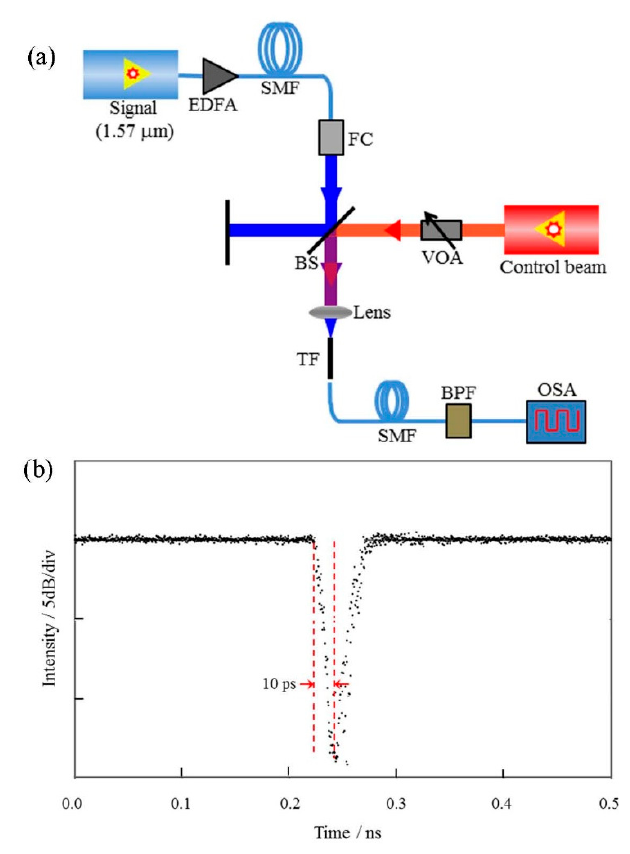
Figure 7. ( a ) Experimental setup for investigating the all-optical signal modulation controlled by the ultrafast single pulse in the all-solid double-clad tellurite PBGF. ( b ) Experimental results of the all-optical signal modulation controlled by the ultrafast single pulse.